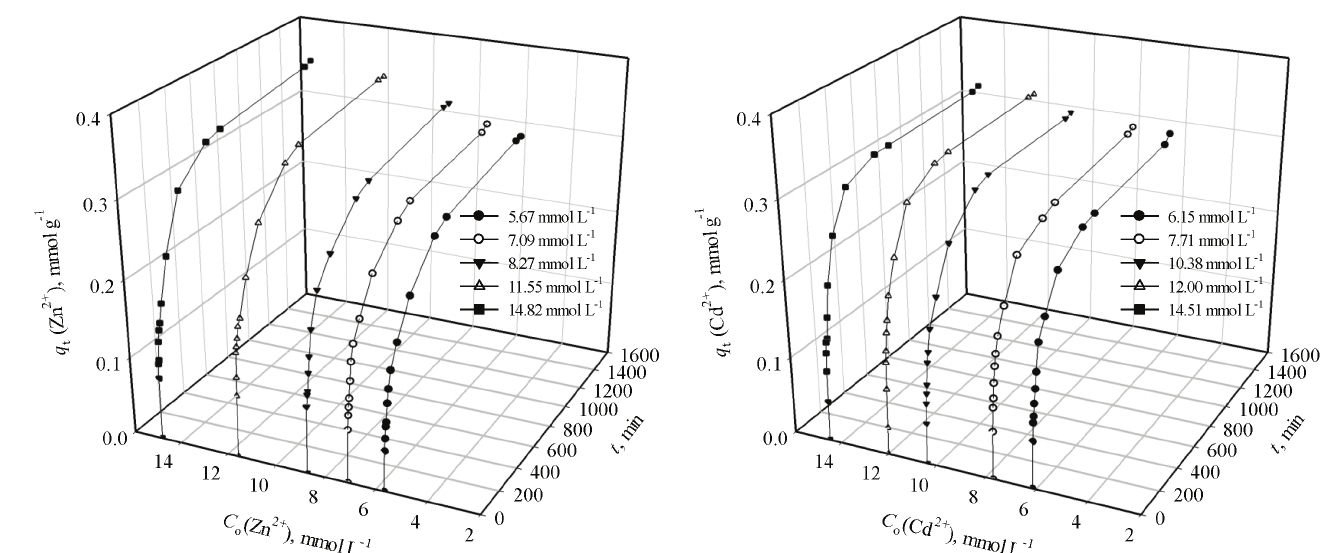
Fig. 2 – Amount of zinc and cadmium uptake per gram of IMZ vs. time and initial